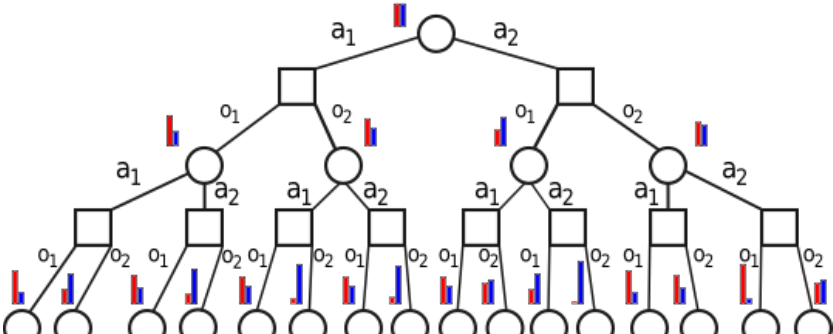
Figure 2. An example of a belief tree of the type constructed by DESPOT. Each circle represents a belief state node, and the squares are action nodes. The bar graph is the belief state associated to a node (only two classes are considered for